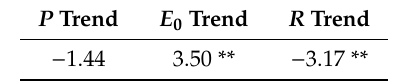
** indicates an extremely significant trend (significance level α = 0.01).